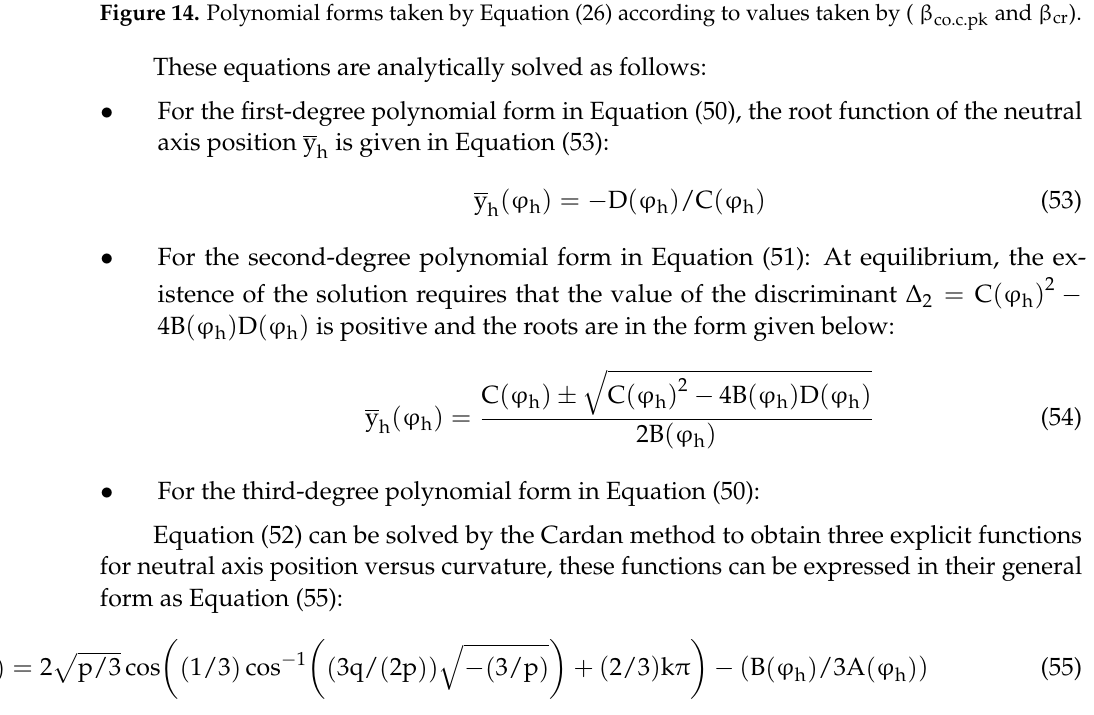
β cr co.c.pk and